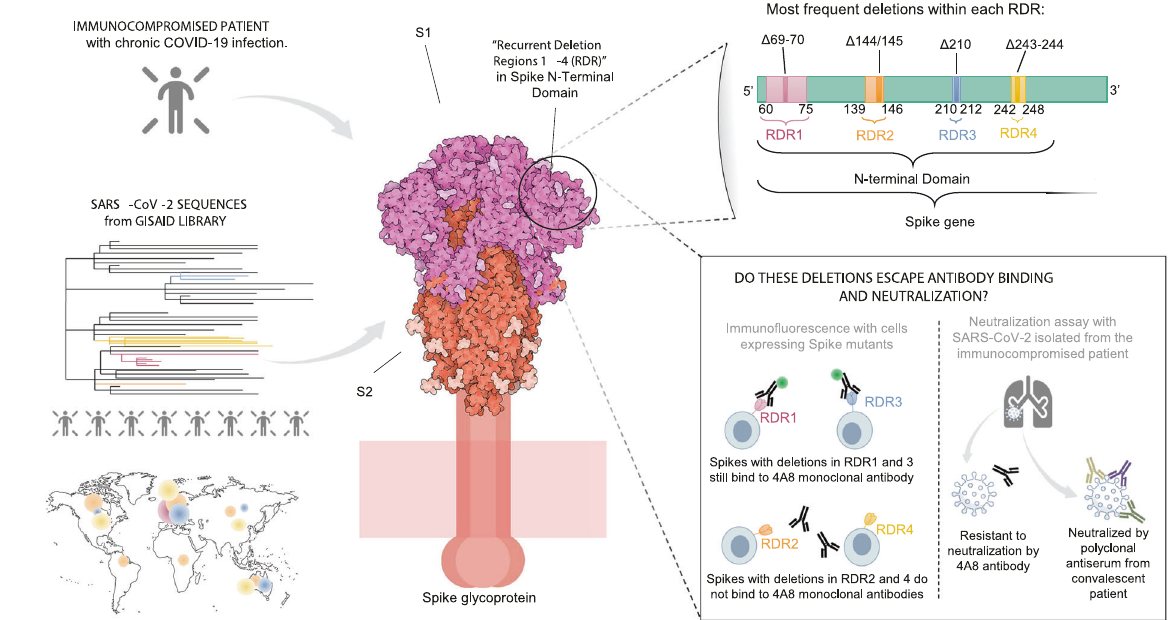
Fig. 1 A pattern of recurrent deletions in the NTD of the Spike was observed by McCarthy et al. RDRs were identi fi ed in an immunocompromised patient, in late but not baseline samples of eight COVID-19 patients and in 1108 sequences originating in diverse geographic sites. Center: representation of SARS-CoV-2 spike by David S. Goodsell and the Research Collaboratory for Structural Bioinformatics Protein Data Bank. Top right: the location of the RDRs is represented and delimited by the numbered amino acid. Bottom right: indirect immuno fl uorescence showed that the RDR2 and RDR4 deletions in S expressed on the surface of Vero E6 cells abrogated the binding of the 4A8 monoclonal antibody. Non-plaque-puri fi ed viral population from the immunocompromised patient showed resistance to neutralization by 4A8, but was neutralized by polyclonal antisera from convalescent